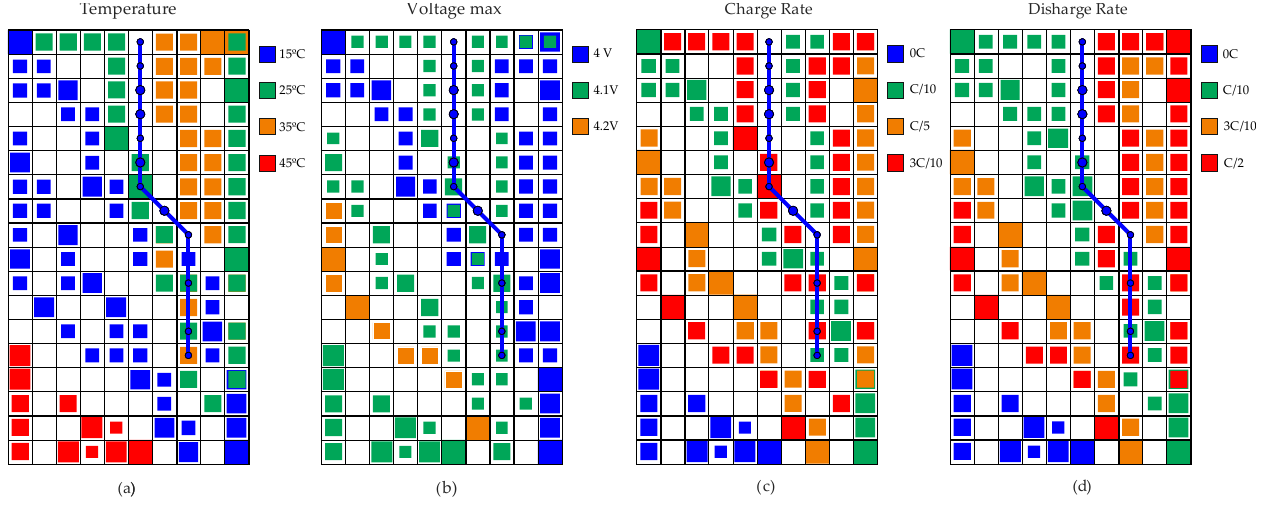
Figure 15. Cell 13 trajectory with different labels to analyze its path on the map. ( a ) Temperature distribution map; ( b ) Maximum charge voltage map; ( c ) Charge current rate distribution; ( d ) Discharge current rate distribution.